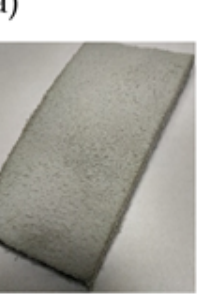
Figure 2. LL2 flat lane ( a ) photography, ( b ) belt cross section, ( c ) optical light microscopy images of the internal structure.